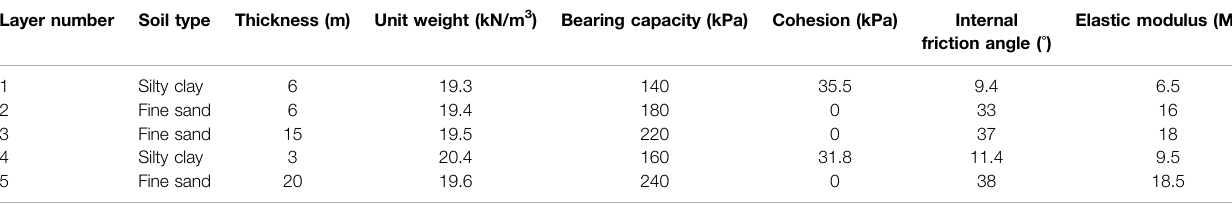
TABLE 2 | Soil parameters used in the numerical calculation.